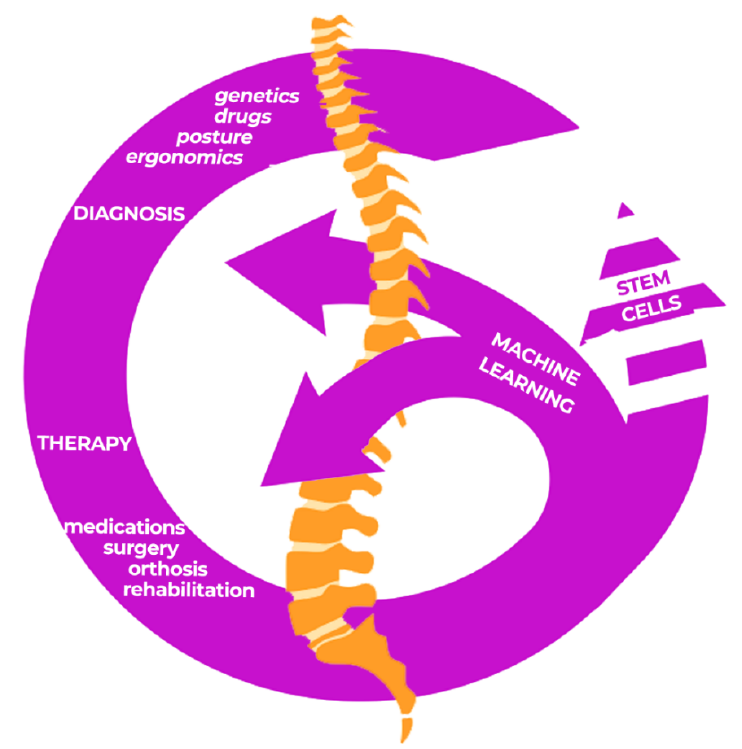
Figure 1. Reframing vertebral-related diseases with machine learning: a closing circle.